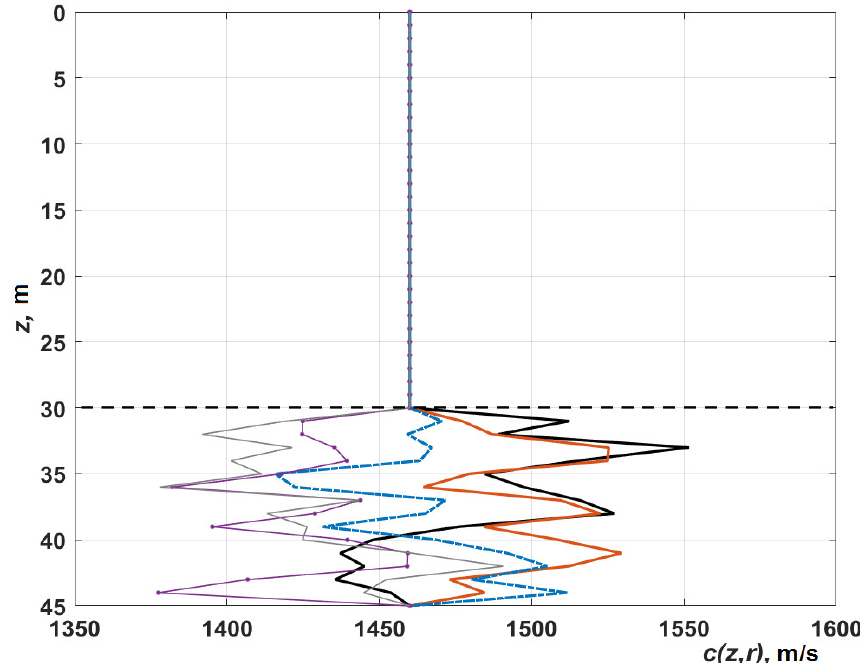
Figure 6. An example of the speed of sound profile in the water and in liquid bottom sediments for five arbitrary random realizations at some distance r from the source. Dashed line at z = 30 m shows the water–bottom interface.